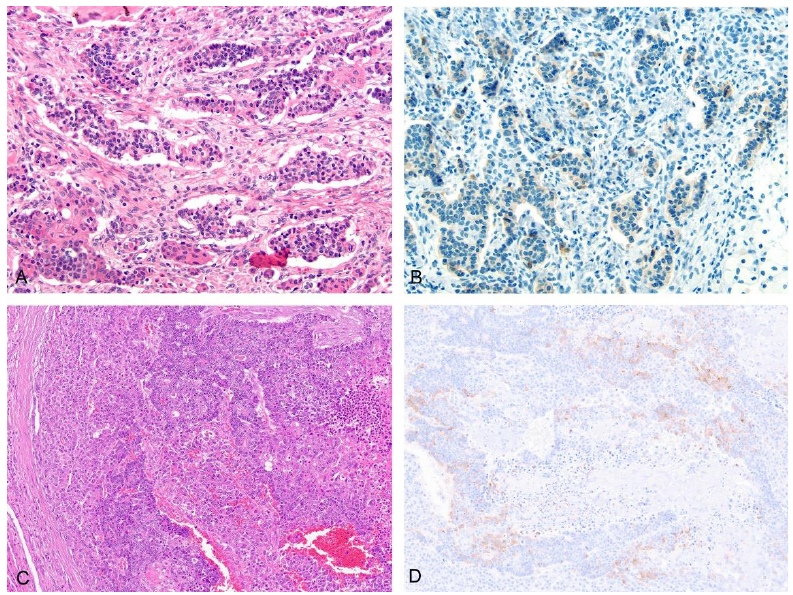
Figure 3. Neuroendocrine-like elements in THB12 and THB25. ( A ) H&E THB12 20x; ( B ) Synapto- physin IHC THB12 20x; ( C ) H&E THB25 10x; ( D ) Synaptophysin IHC in THB25 10x. In those patients with metastasis, four had teratoid elements present at distant metastatic sites (THB12, THB15, THB20, THB23) consisting of ganglion cells, melanin, primitive glands or yolk-sac-tumor-like elements. In two cases, distant metastases were composed entirely of yolk-sac-tumor-like elements (THB12, THB23). One case initially had omental and extrahepatic tumors with mixed fetal, embryonal, and teratoid elements (Figure 4) and subsequently developed peritoneal metastases exclusively composed of tubulopapillary yolk-sac-tumor-like areas (Figure 5A,B, THB23). Cancers 2022 , 14 , x FOR PEER REVIEW